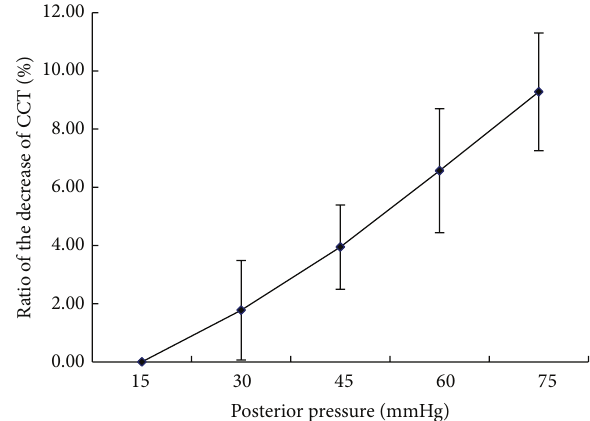
Figure 1: The change of central corneal thickness (CCT) of rabbit eyes with the increase of posterior pressure. The ratios − of the decrease of CCT were calculated as ( CCT 15 mmHg )/ CCT CCT 15 mmHg , where CCT 15 mmHg was viewed as posterior pressure the initial thickness of the cornea. The ratios were shown linearly with the increase of posterior pressure ( 𝑅 2 = 0.9928 ).